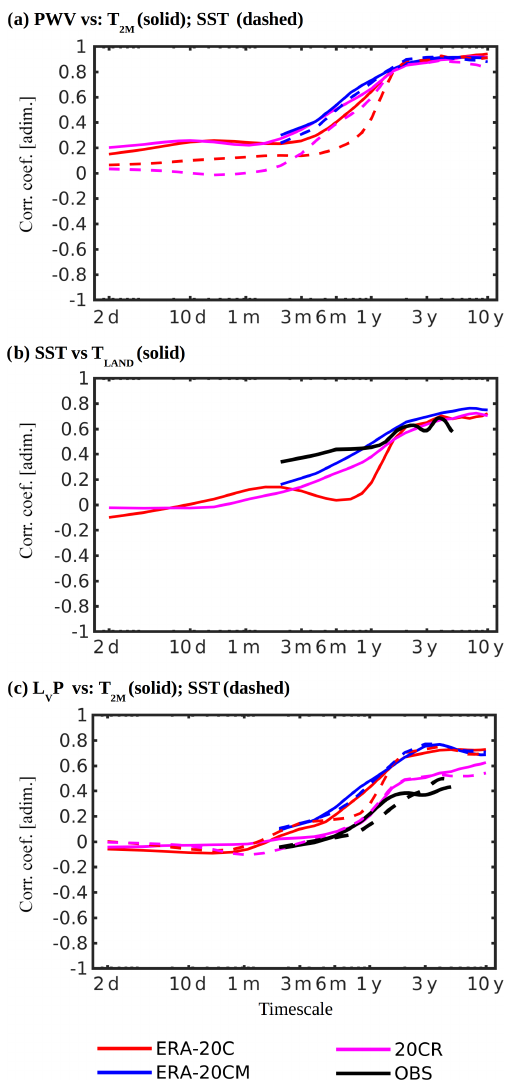
Figure 1. Cross-correlation coefficients against temporal scale computed from Haar fluctuations for global-mean time series of (a) PWV vs. T 2m (solid) and PWV vs. SST (dashed); (b) SST vs. T land ; and (c) L v P vs. T 2m (solid) and L v P vs. SST (dashed). Red lines represent results from ERA-20C, blue lines are from ERA-20CM, pink lines are from 20CR, and black lines are esti- mated from observational